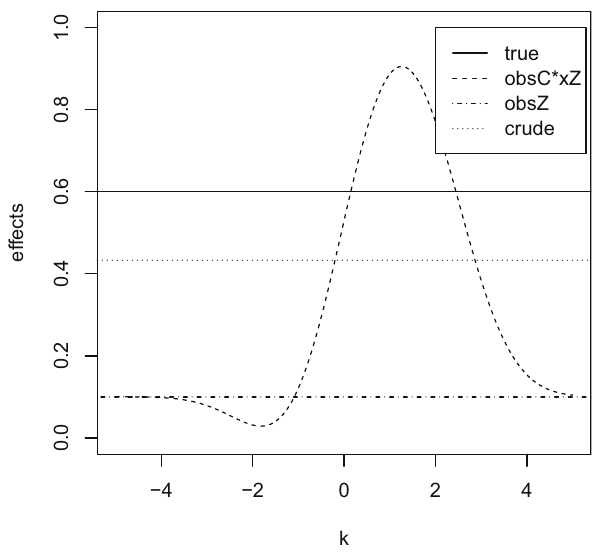
Figure 7: True, observed, and crude e ff ects as functions of the cuto ff k in Setting